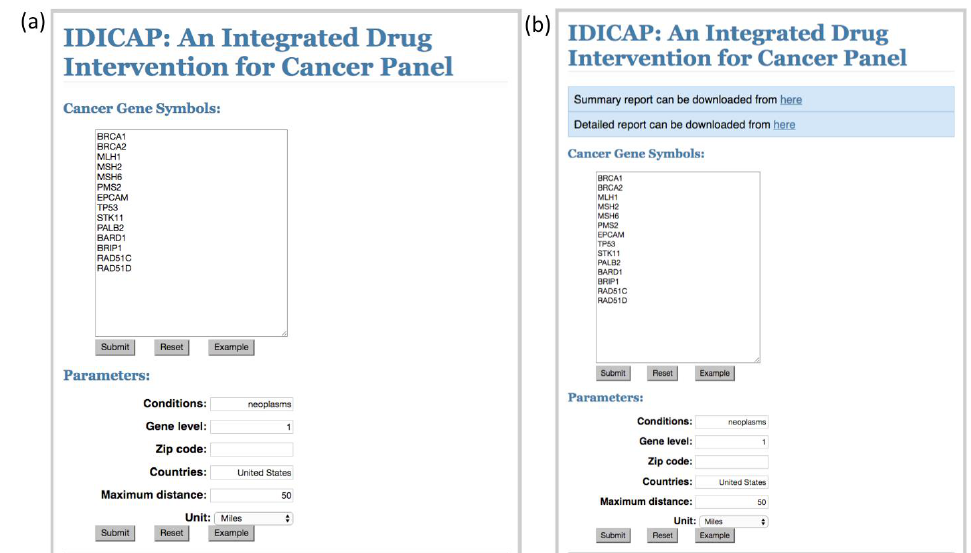
Figure 5. IDICAP web interface and control parameters. ( a ) User enters a list of human gene symbols in the cancer gene symbols box, gene symbols must be separated by at least a space, and they may span multiple lines. IDICAP will search for drugs and clinical trials that target these genes. Conditions box specifies the cancer type targeted by the clinical trials or drugs in neoplasm-specific MeSH terms. If the search involves more than one cancer type, separate the condition names by a comma (e.g., “breast cancer, ovarian cancer”). Gene level indicates the maximum level of protein-protein interaction to regress. See Section 4.6 for the details. Zip code , countries , maximum distance , and unit are parameters used by the proximity checking function. Refer to Section 4.5 for the detailed discussion.